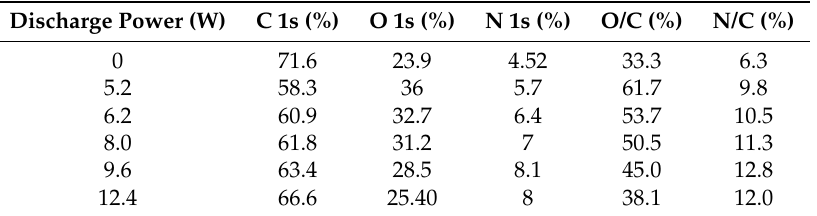
Table 1. XPS elemental analysis of the pristine and plasma-treated polyimide as a function of discharge power at He-H 2 O flow rate of 10 L/min and treatment time of 30